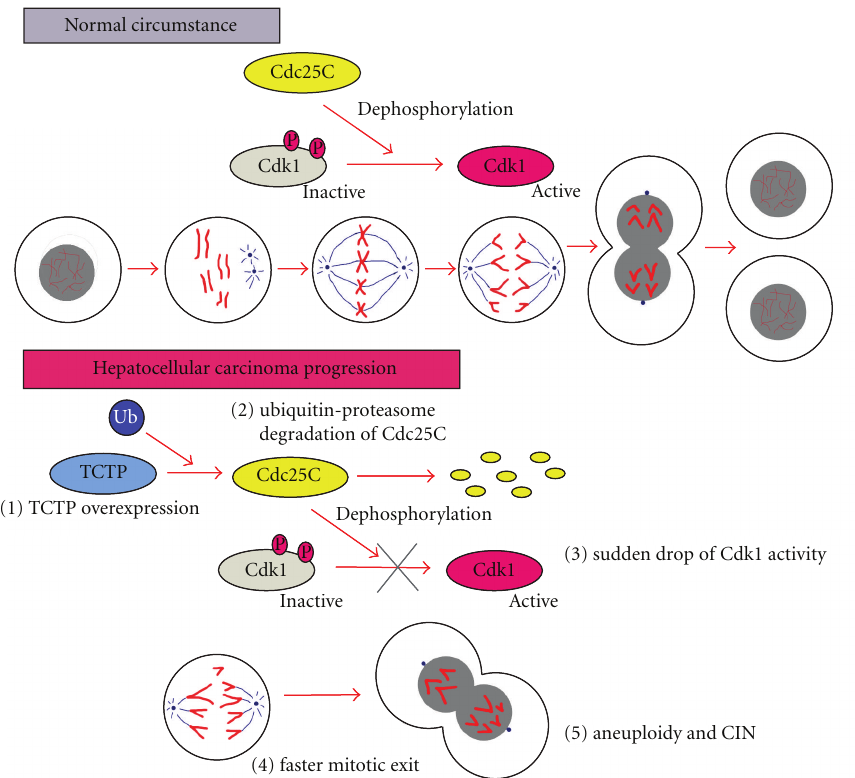
Figure 1: Mechanistic diagram showing the e ff ect of abnormal regulation of TCTP/Cdc25C/Cdk1 pathway in HCC development. (Upper panel) Under the normal mitotic progression, Cdc25C activates Cdk1 by the dephosphorylation of Thr14 and Tyr15 in Cdk1. The level of active Cdk1 is a key factor for maintaining the mitotic state and functions as a key switch for cell division. (Lower panel) During the HCC development, TCTP is overexpressed in over 40% of HCC cases. Overexpression of TCTP promotes the ubiquitin-proteasome degradation of Cdc25C, which leads to the failure in the dephosphorylation of Cdk1 on Tyr15 and decreases Cdk1 activity. As a consequence, the sudden drop of Cdk1 activity in mitosis induces a faster mitosis exit and chromosome missegregation, which leads to aneuploidy and CIN, finally causing cancer